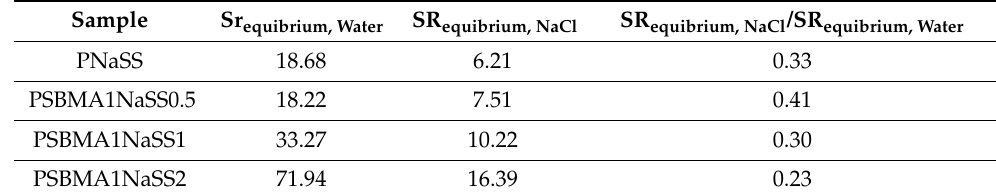
Table 1. SR equibrium of zwitterionic copolymer hydrogels in water and NaCl solution (1 mol/kg) at room temperature. Reproduced from [49]. Copyright 2019, American Chemical